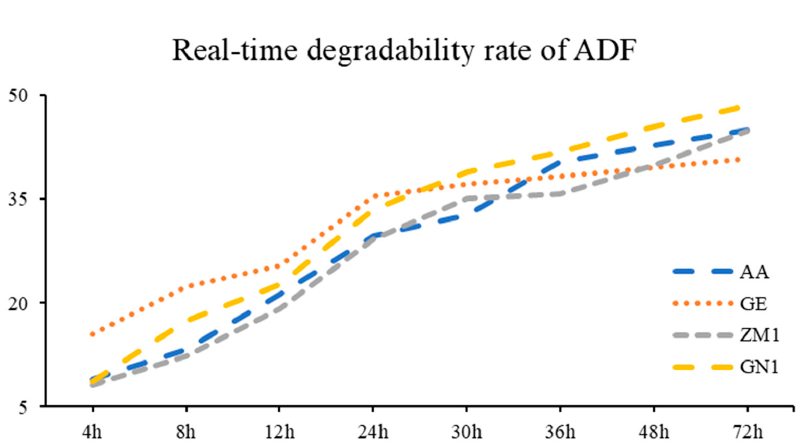
Figure 4. The real-time degradability rate of ADF in different alfalfa hay cultivars. AA: American Anderson, GE: American Golden Empress, ZM1: Zhongmu No. 1, GN1: Gongnong No. 1.